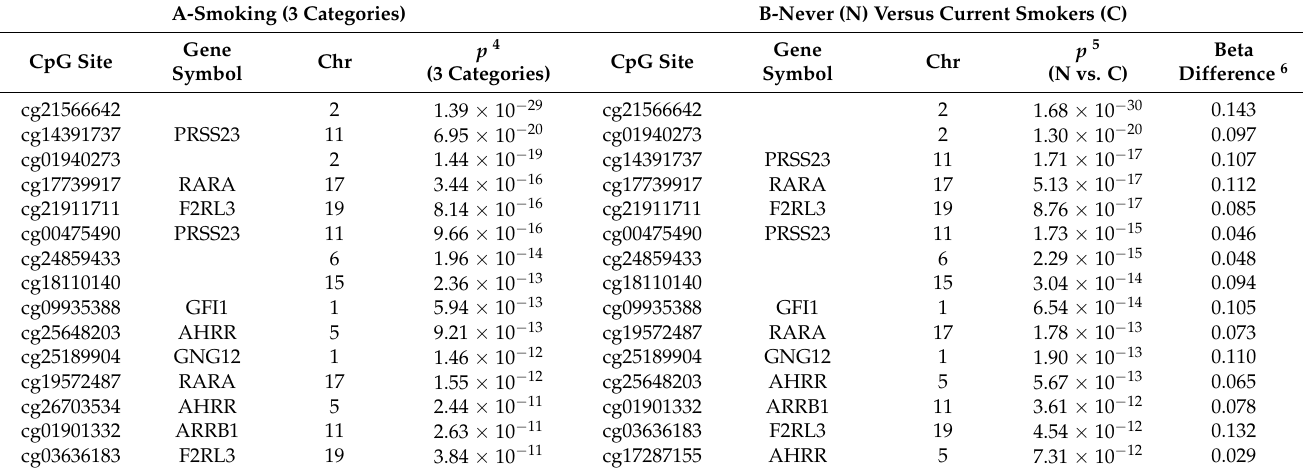
Table 3. Top-ranked (15) differentially methylated CpGs for smoking status (3 categories) 1 : (A) and for never smokers (N) relative to current smokers (C) 2 ; (B) ranked by smallest p -value after multivariate adjustment 3 .